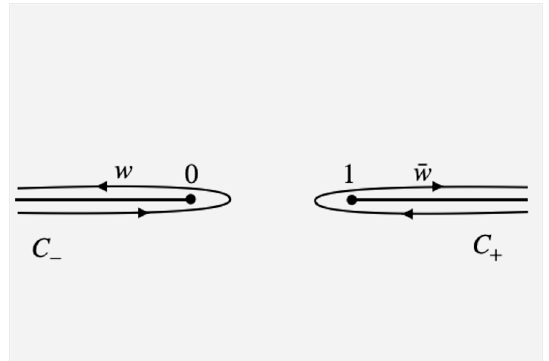
Figure 2 . Contour prescription for the general functional (5.10). The w variable is integrated over contour C and ¯ w over C . All the dual basis functionals α s − + for suitable integral kernel H ( w, ¯ w )